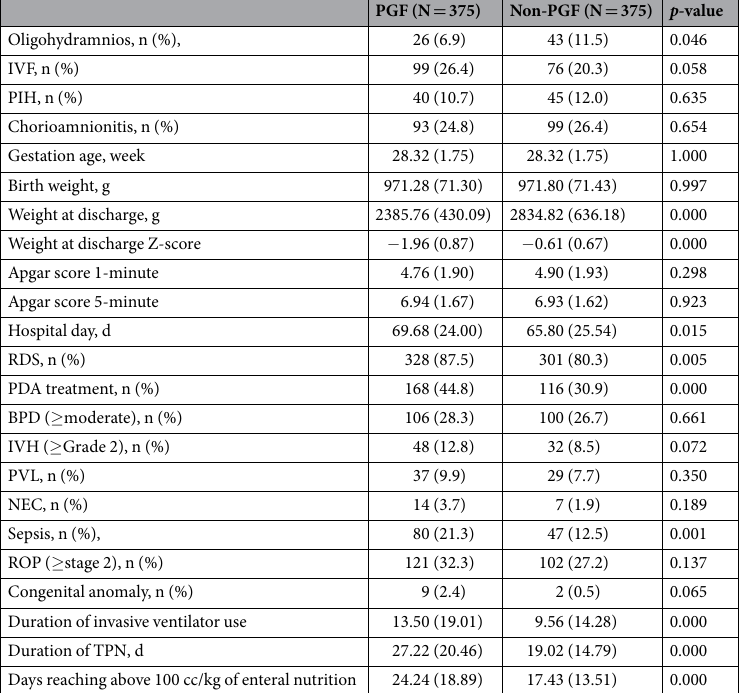
Table 3. Comparisons of relevant patient demographics and morbidity between the postnatal growth failure (PGF) and non-postnatal growth failure (Non-PGF) groups specifically among infants with a weight appropriate for gestational age (AGA) after propensity score matching. Data are presented as numbers of patients (%) or mean (SD). PGF, postnatal growth failure; IVF, in vitro fertilization; PIH, pregnancy induced hypertension; RDS, respiratory distress syndrome; PDA, patent ductus arteriosus; BPD, bronchopulmonary dysplasia; IVH, intraventricular haemorrhage; PVL, periventricular leukomalacia; NEC, necrotizing enterocolitis; ROP, retinopathy of prematurity; TPN, total parenteral